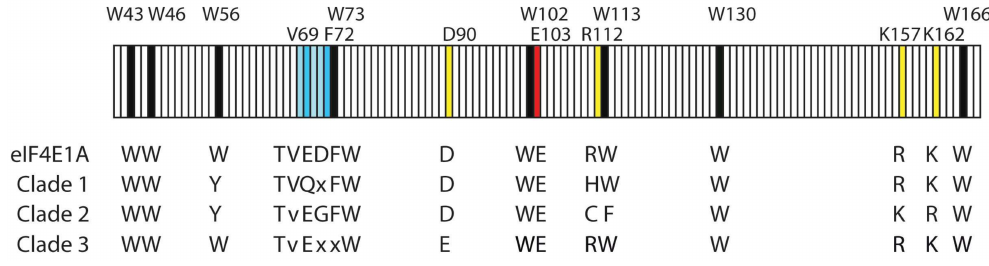
Figure 3. A 130-amino acid conserved core of the mammalian eIF4E1A (subclade1a) illustrating the important binding regions for the m 7 G cap and eIF4G. The eight conserved tryptophan residues (numbered as for the mammalian sequence) are shown in black along with the residues that are found at the corresponding positions in representative sequences from the three dinoflagellate clades. Residues in yellow are important for binding the phosphates of the m 7 G (the aspartate at position 90 coordinates binding by arginine-157), while the eIF4G binding motif (S/TVxxFW) is shown in blue. The small v in the eIF4G binding motif could also be T (for clade 2) or A (for clade 3). The glutamate at position 103 (red) is involved in hydrogen bonding to the m7G. Note that dinoflagellate clade 1 eIF4Es have an insertion of 12–13 amino acids between W73 and W102, as well as an insertion of 7–9 amino acids between W130 and W166. Figure based on